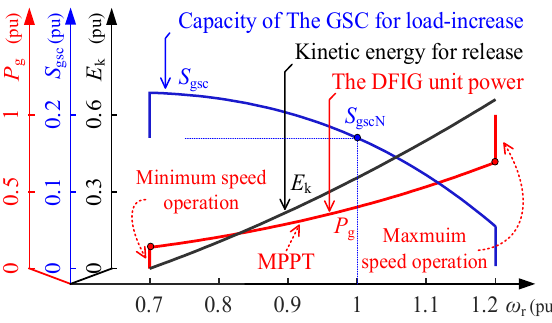
0.7 Figure 7. Load-increase capacity of GSC and effective rotor kinetic energy at different rotor velocities.